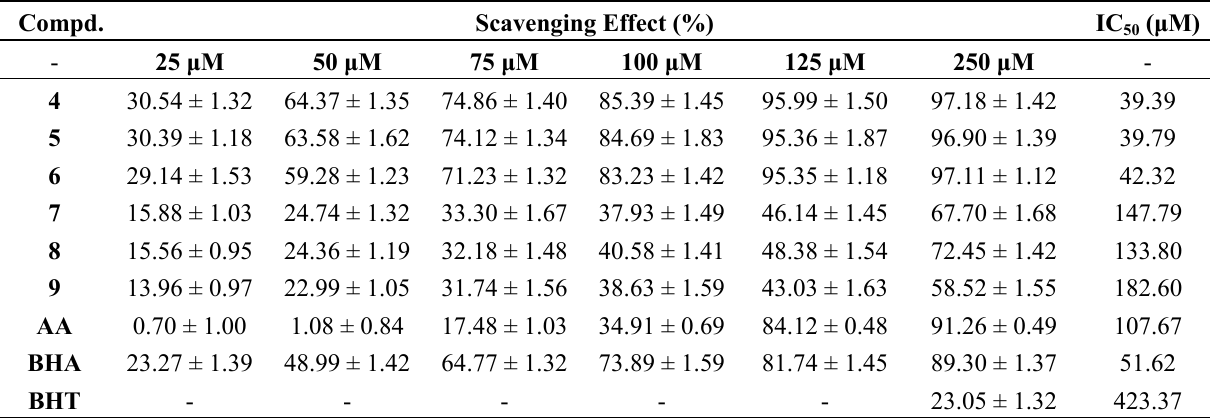
Table 1. Antioxidant activity of compounds 4 – 9 by DPPH method.